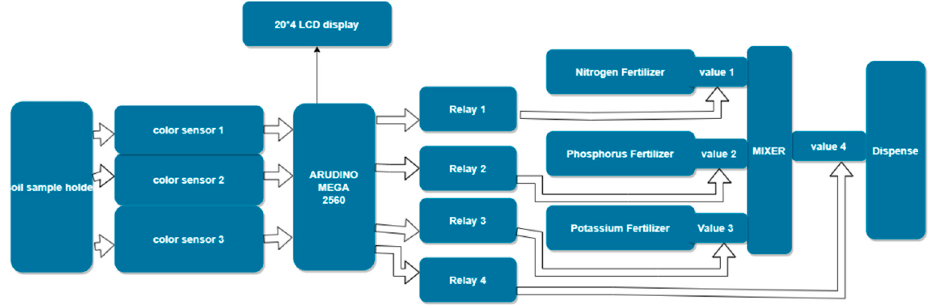
Figure 2. Block representation of the suggested system by Amrutha A et al. [11].